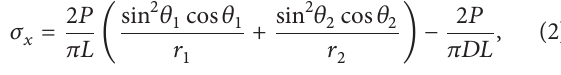
The upper and the lower limit and the average load were represented by 𝑃 max , 𝑃 min , and 𝑃 0 , respectively; the amplitude − 𝑃 Δ𝑃 = 𝑃 max min in Figure